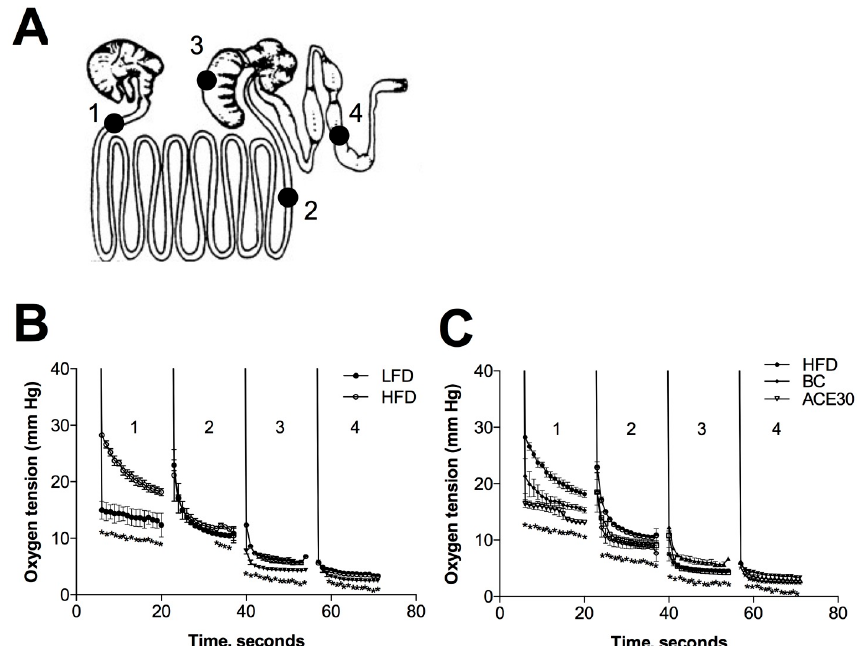
Figure 6. Gut luminal oxygenation profiles of different gastrointestinal regions of mice following 12-week berry supplementation: ( A ) schematic representation of mouse gastrointestinal tract including duodenum (1), ileum (2), cecum (3), and colon (4) sections; ( B ) oxygen tension curves of LFD and HFD animals indicated significant increases in gut luminal oxygen content of the HFD animals; and ( C ) oxygen tension curves in mice supplemented with blackcurrant or blackcurrant anthocyanins (ACE30 extract) showed decreased oxygen concentration within the gastrointestinal lumen when compared to HFD controls. Data are reported as means ± SEM. * p < 0.05 when compared to by two-factor repeated measures ANOVA.